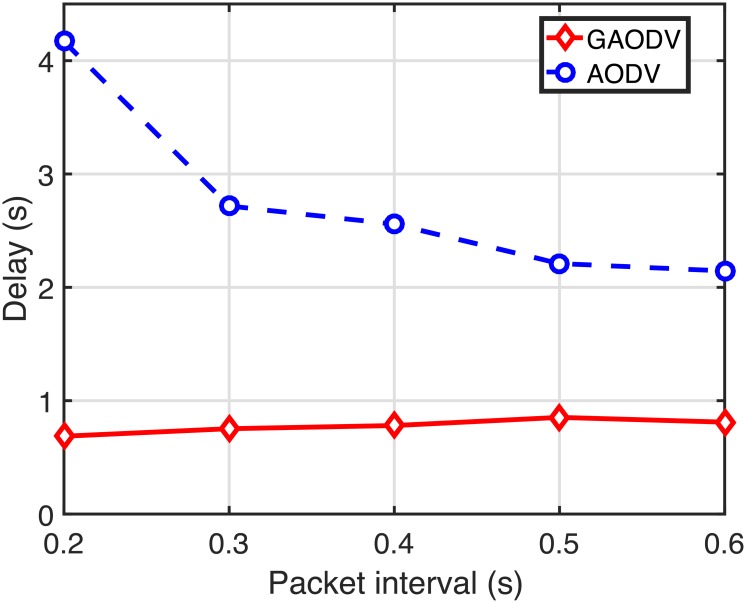
Delay for the change of the packet interval when NCBR = 10 and vmax = 5 m/s.